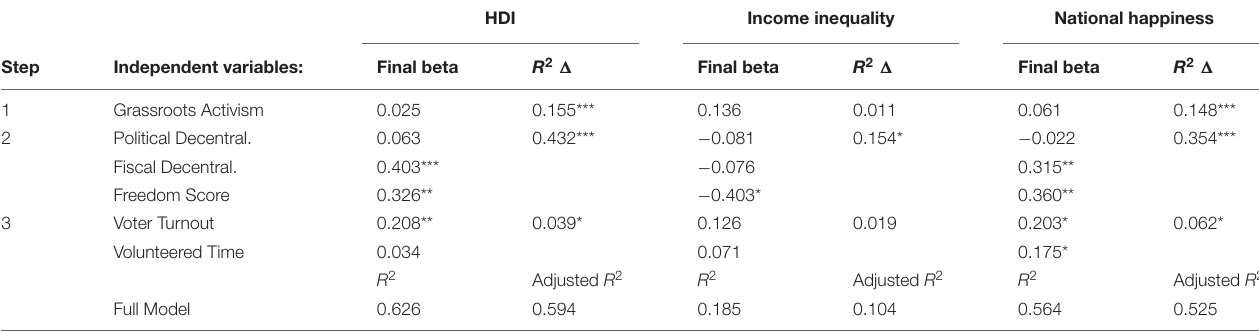
TABLE 3 | Standardized beta coefficients and R 2 increments a in hierarchical multiple regressions predicting different measures of national well-being.